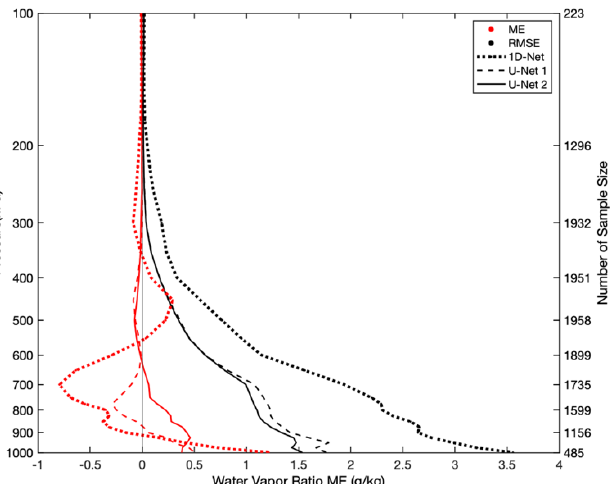
Figure 14. Water vapor mixing ratio retrieval error profiles compared with radiosonde under clear FOVs for February 2021. The color and line shape denote the same as Figure 10.